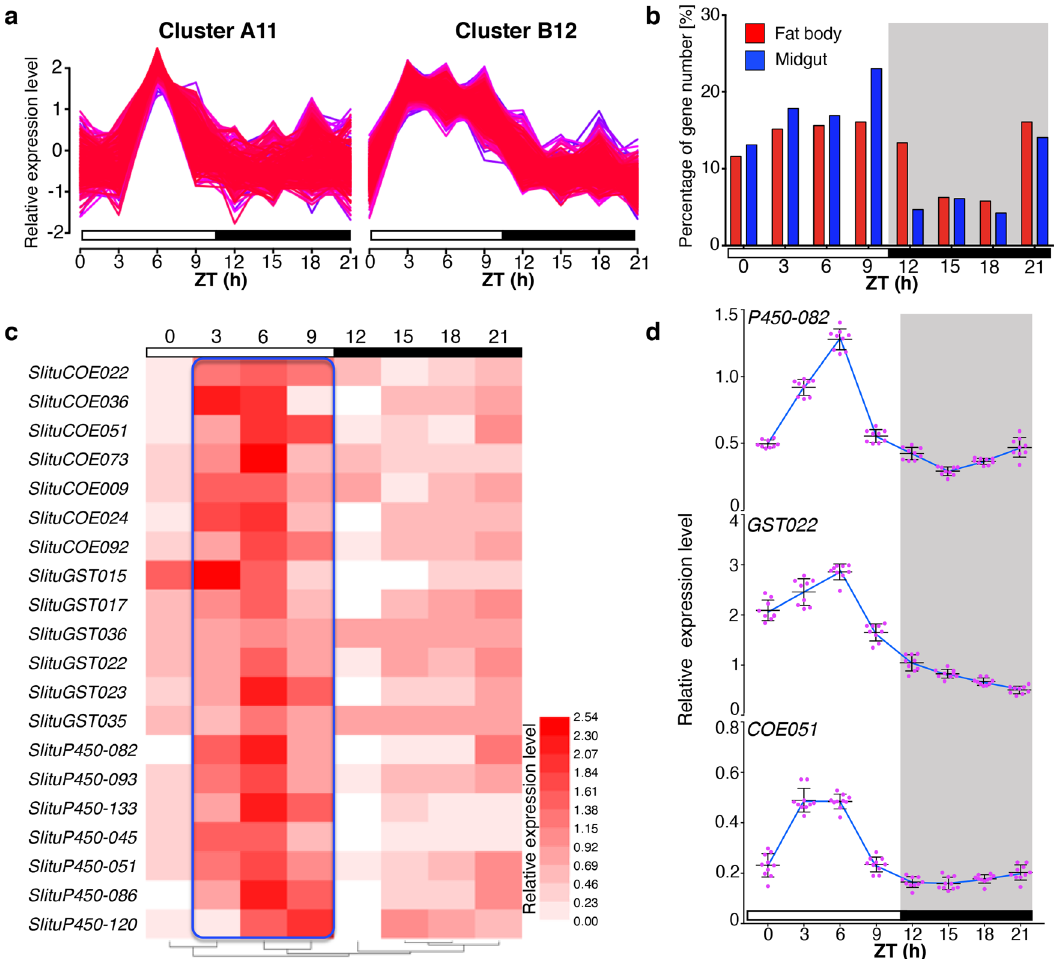
Fig. 2 Oscillation of detoxi fi cation gene expression in the fat body and midgut. a Clustering of genes with the same expression pattern in the midgut (Cluster A11) and fat body (Cluster B12). The expression values were processed using Mfuzz software with the method of homogenization by log10. b The percentage of detoxi fi cation genes with peak expression at speci fi c time points in the fat body and midgut. c Expression heatmap of selected detoxi fi cation genes. d RT-qPCR analysis of representative detoxi fi cation genes from each of the three major families, P450-082 (top), GST022 (middle), and COE051 (bottom). Each experiment was performed with fat bodies from 3 6LD2 larvae and was repeated independently three times. Error bars represent SEM, photophase is represented by white rectangles, and scotophase by black rectangles and black